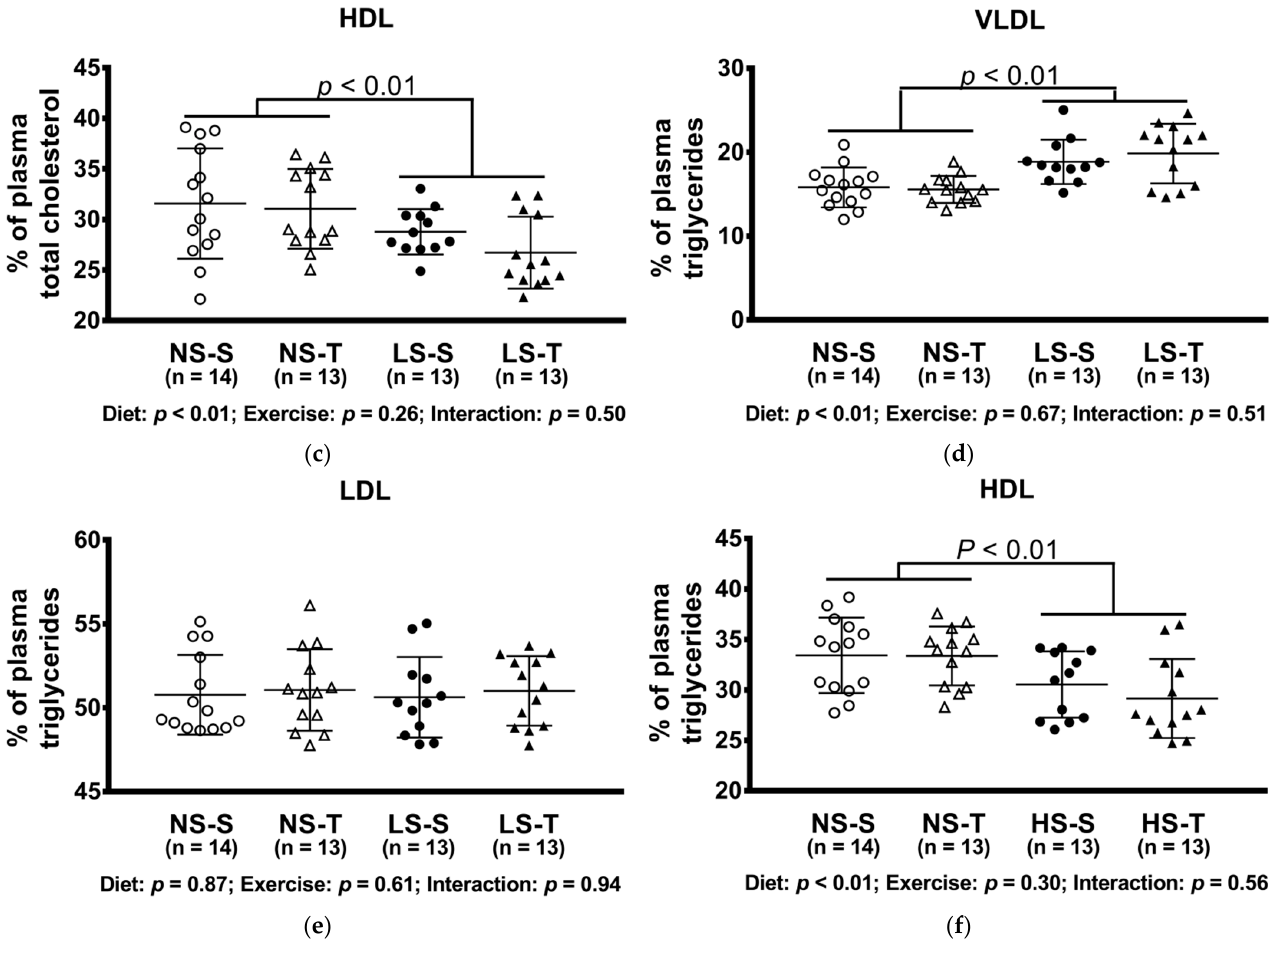
Figure 4. Percentual of plasma lipids in lipoproteins determined by FPLC . ( a ) VLDLc; ( b ) LDLc; ( c ) HDLc; ( d ) VLDLtg; ( e ) LDLtg; ( f ) HDLtg. Data presented as mean ± SD. Results compared by 2-way ANOVA (GLM; fixed factor: diet and exercise) with Tukey’s post hoc test. p values show differences between diets. NS = normal-sodium diet; LS = low-sodium diet; S = sedentary; T = trained.